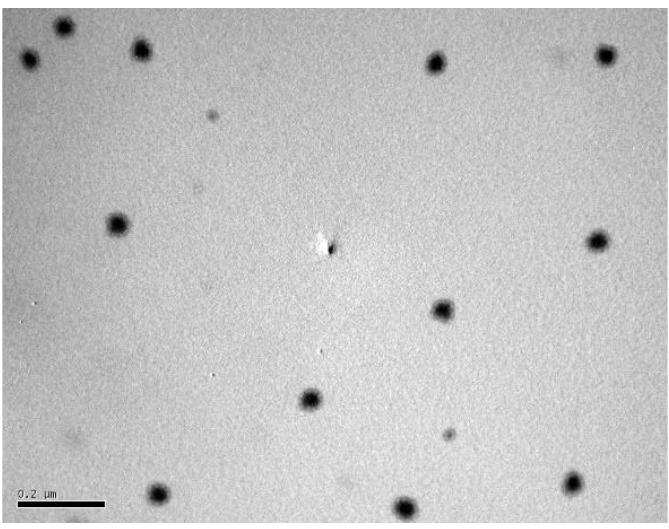
Figure 3. Transmission electron microscopy photo of TTO-SLN1.